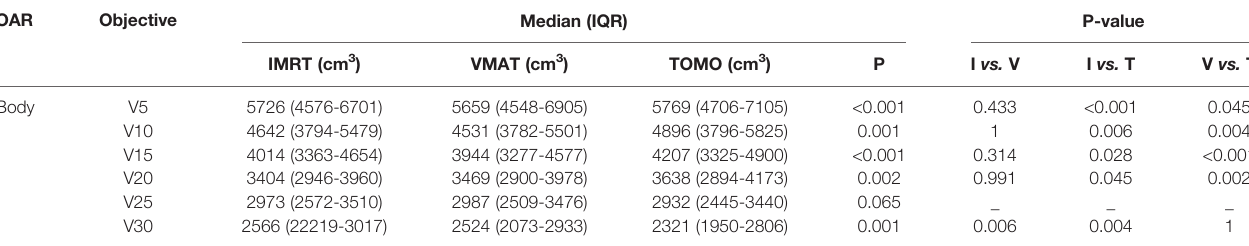
TABLE 7 | Low-dose radiation volume of IMRT, VMAT and TOMO in T 1-2 NPC